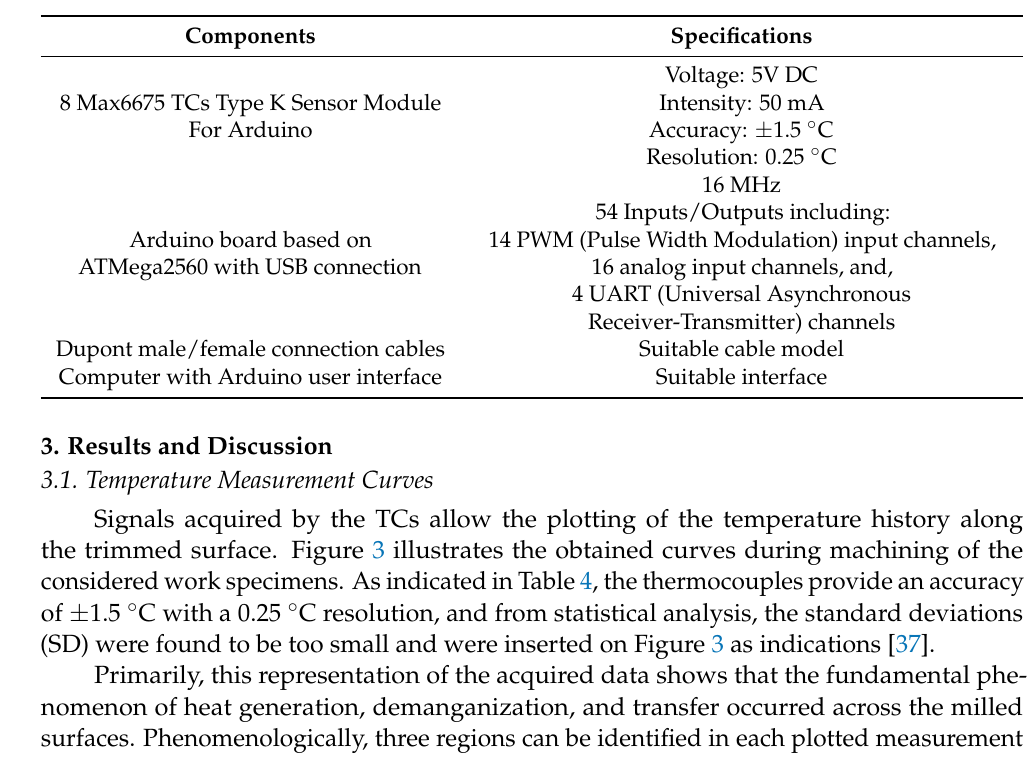
Table 4. Technical characteristics of data acquisition instruments